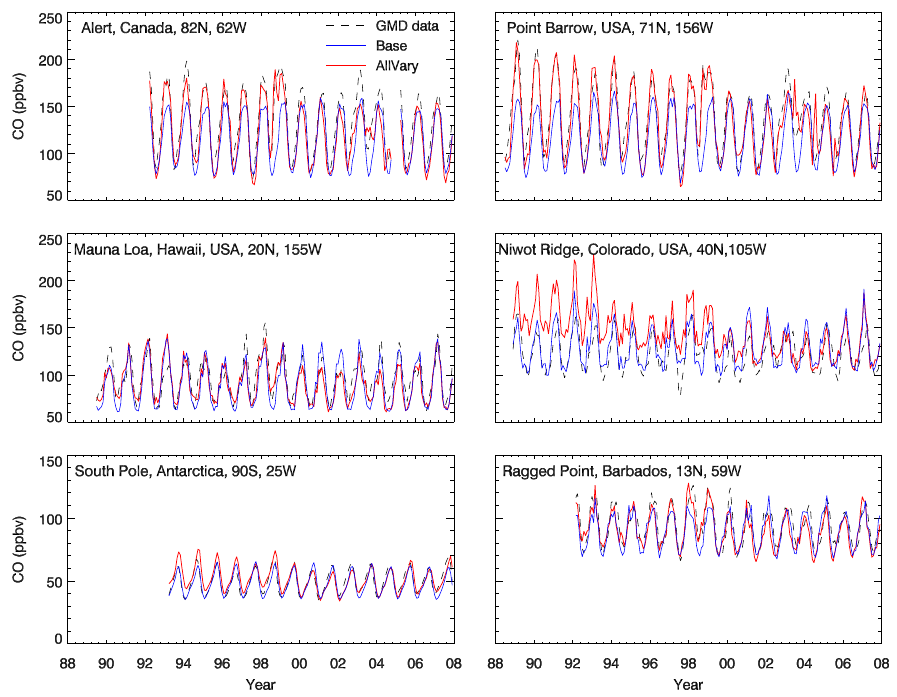
Figure 9. Monthly CO (ppbv) from the Base and AllVary scenarios and observations from six GMD stations. Similar plots for the other scenarios are given in Figs. S13 to